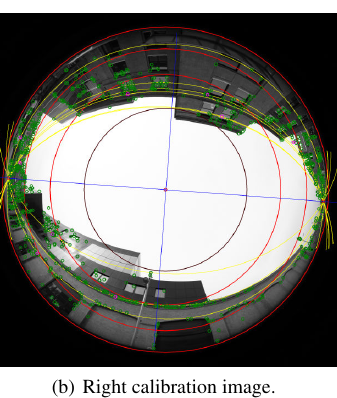
Figure 6: Illustration of the calibration for a couple of real images taken with the Sigma